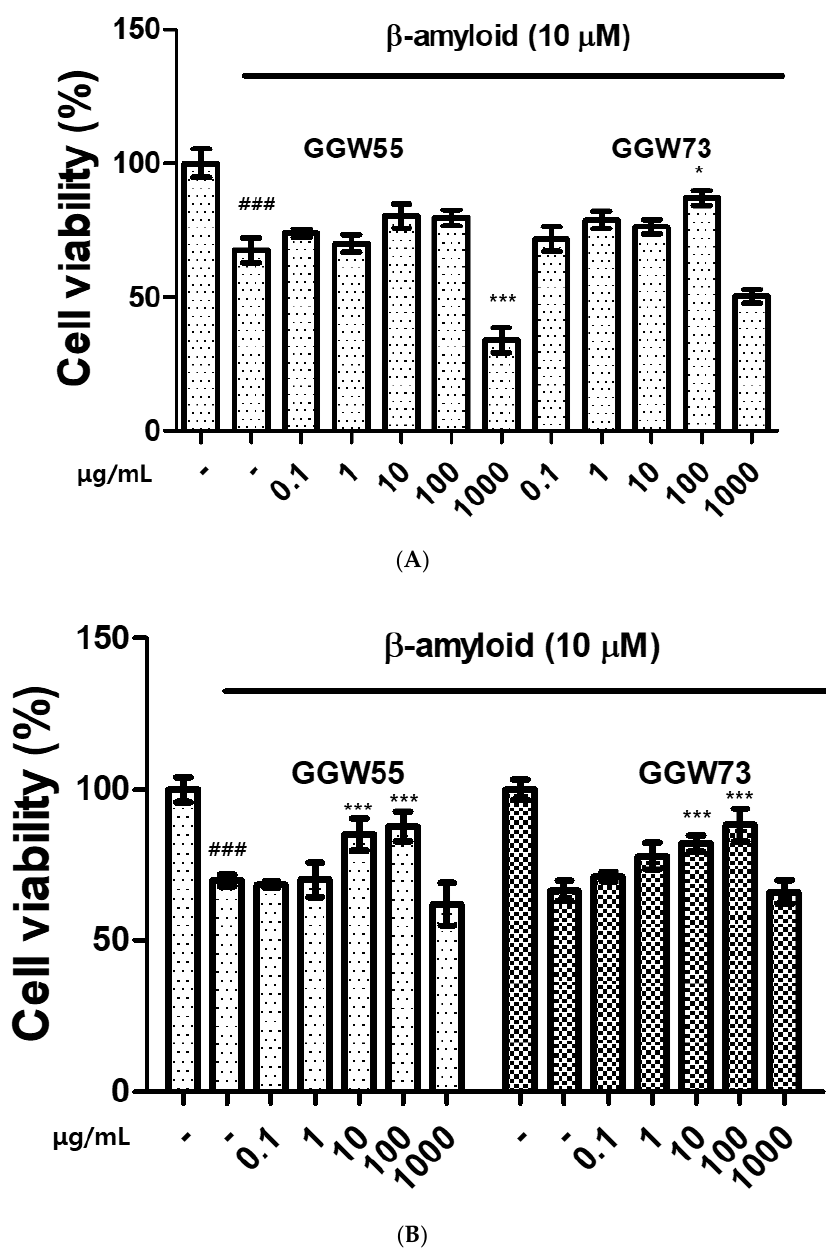
Figure 2. The protective effect of GGW on Aβ -treated neuronal cells. The protective effect of GGW55 and GGW73 on Aβtreated SH − SY − 5Y cell and SK-N-SH cell. The cells were treated with and GGW73 on A β treated SH-SY-5Y cell and SK-N-SH cell. The cells were treated with GGW55 and GGW55 and GGW73, after 4 h Aβ (10 μM) were treated for 24 h. Cell viability was evaluated with GGW73, after 4 h A β (10 µ M) were treated for 24 h. Cell viability was evaluated with absorbance of absorbance of formazan crystal. ( A ) SH − SY − 5Y cell. ( B ) SK − N − SH cell. All values are expressed as formazan crystal. ( A ) SH-SY-5Y cell. ( B ) SK-N-SH cell. All values are expressed as the mean ± S.E.M the mean ± S.E.M from three independent experiments.; ### p < 0.001 compared with none-treat- from three independent experiments.; ### p < 0.001 compared with none-treatment group; * p < 0.05 ment group; * p < 0.05 compared with none-treatment group, *** p < 0.001 compared with only Aβ− treatment group. compared with none-treatment group, *** p < 0.001 compared with only A β -treatment